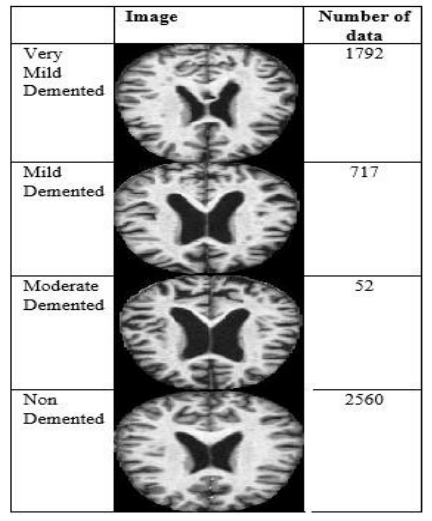
Figure 2. Multi Class Images .